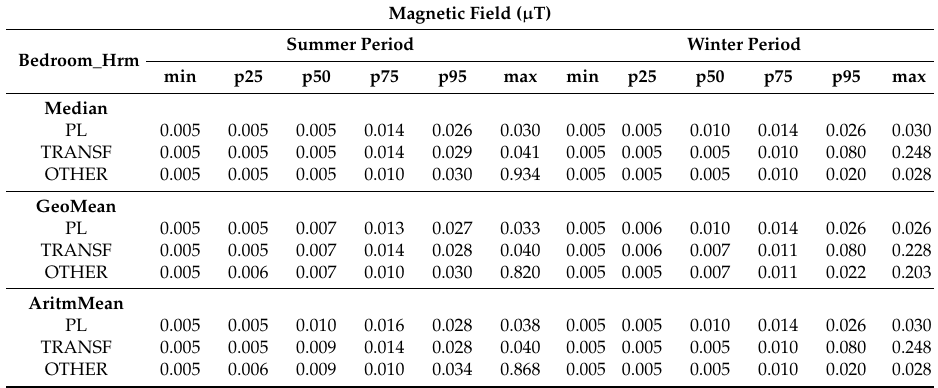
Table A4. Distribution values of the median, geometric mean (geomean) and arithmetic mean (aritmean) of magnetic field ( µ T) in the harmonic (Hrm) frequency range (100–800 Hz) for bedroom measurements for each group (PL, TRANSF, OTHER) in both summer and winter